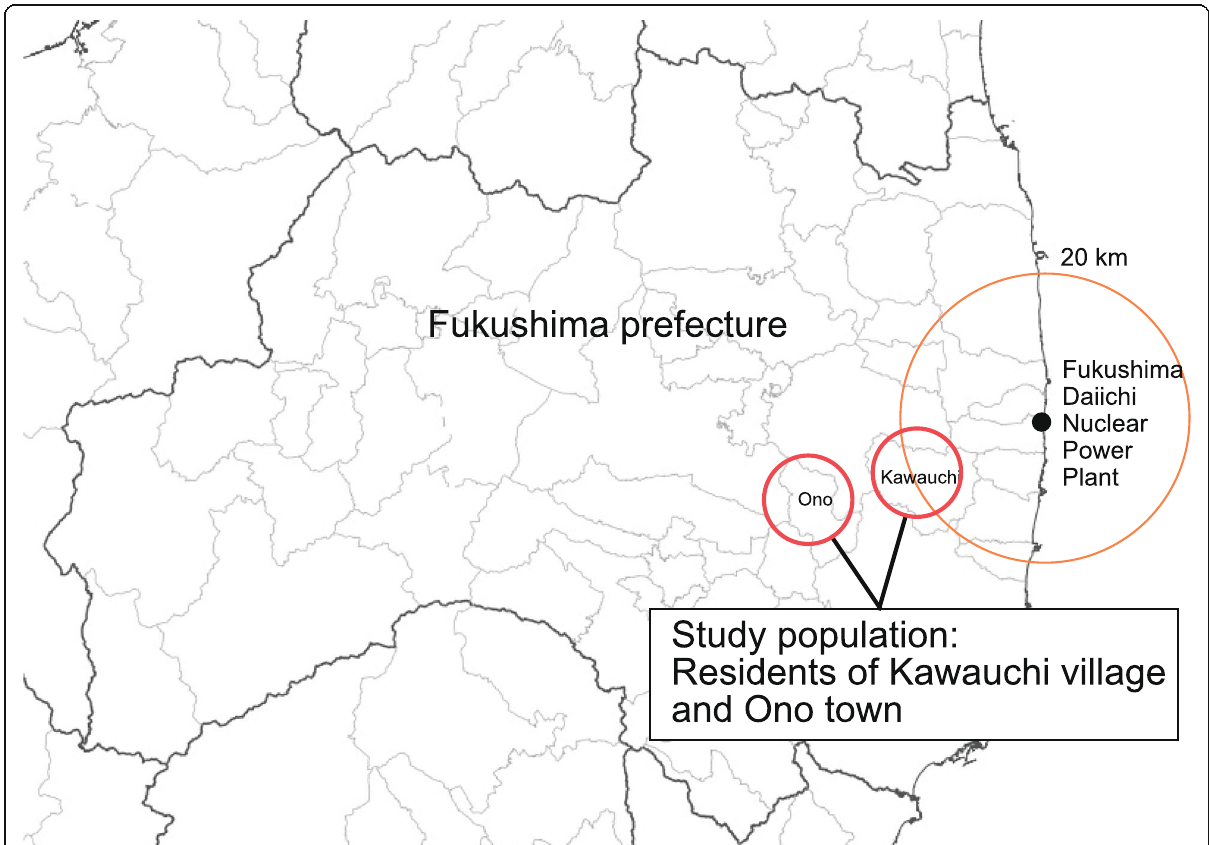
Fig. 1 Geographical relationship between the study sites and the Fukushima Daiichi nuclear power plant. The red dotted line shows a 20-km radius of the evacuation zone. Part of Kawauchi village was included in a mandatory evacuation zone. Ono town, used as a control setting in our study, is 5 km from Kawauchi